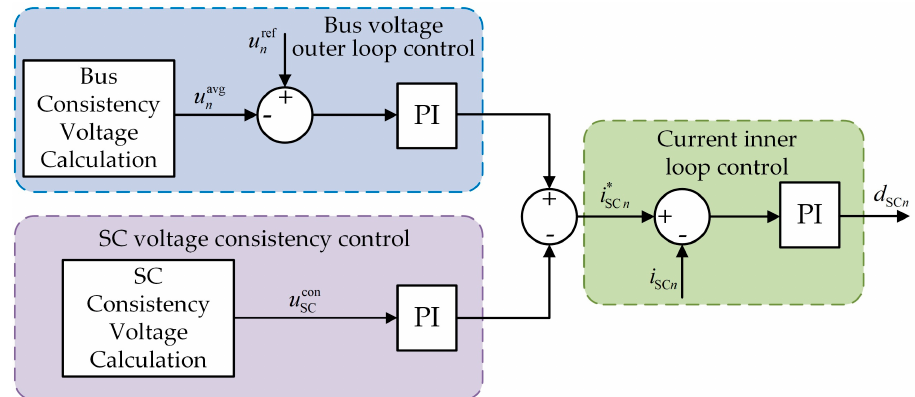
Figure 12. Control scheme of the SC controller for bidirectional DC–DC converter 1. Based on the consistency algorithm, the ESB controller is used to balance the charge state of the ESB. However, when the bus voltage fluctuates, the SC responds quickly to stabilize the bus voltage, and a voltage control loop needs to be incorporated to maintain the end voltage level of the SC. The resulting control strategy to improve the voltage outer loop and current inner loop is shown in Figure 13. The SC voltage control is simultaneously added to the controller outer loop with the SOC consistency control. Its output value corrects the reference current of the ESB, and finally the control target can be achieved.